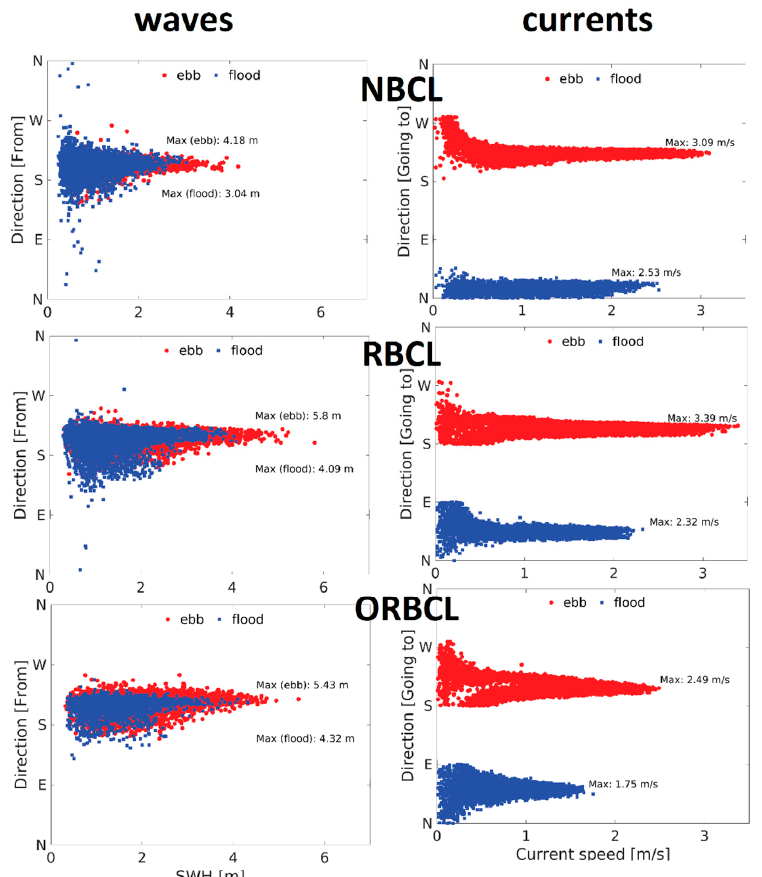
Figure 4. Scatter plots compare the significant wave height and the mean wave direction ( left pan- els ) and the deep-averaged current speed and the direction ( right panels ) measured by bottom- mounted sensors (e.g., AWAC) within the entrance of PPB between 2006 and 2012 at NBCL ( top panel ), RBCL ( middle panel ) and ORBCL ( bottom panel